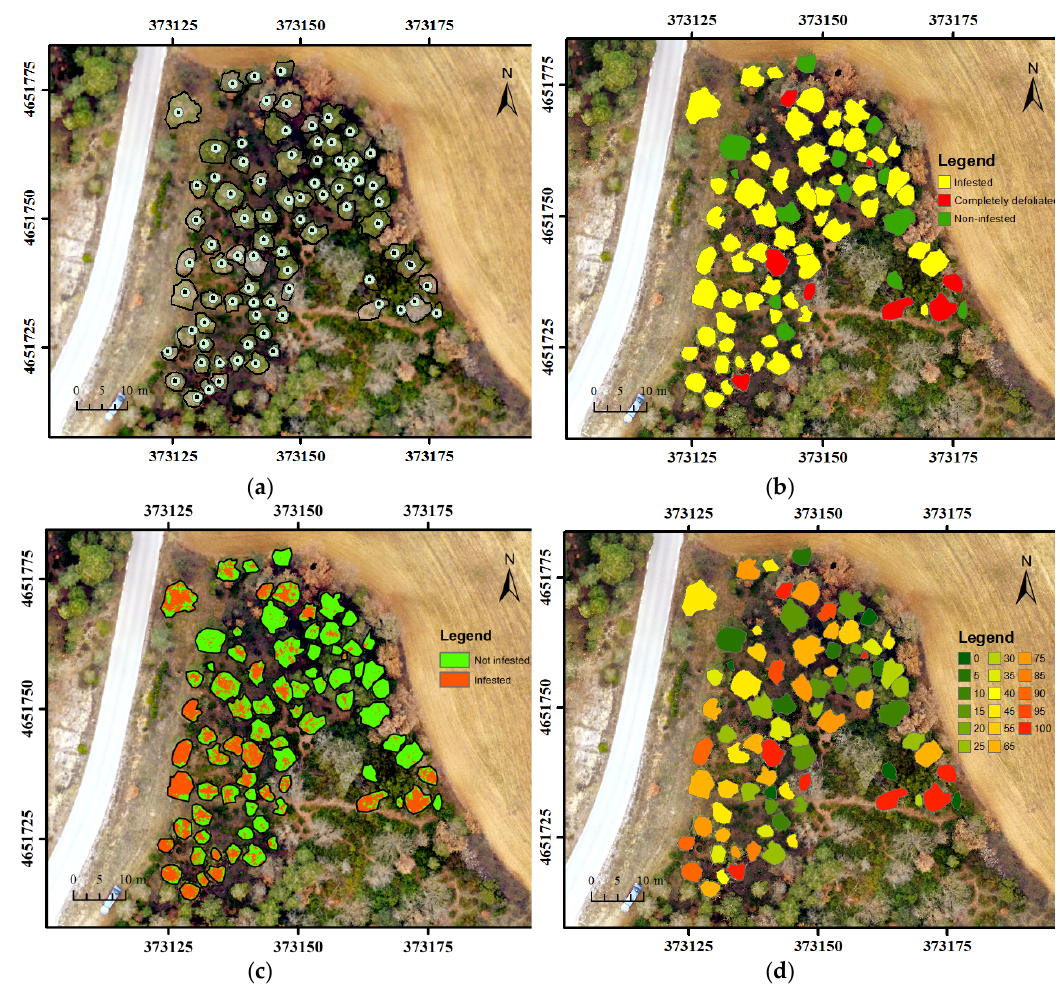
Figure 3. Pine processionary moth defoliation in the Torregassa forest site: ( a ) Manual segmentation of analyzed trees and a buffer of 1 m from the tree automatic identification point (blue segment) on the orthomosaic; ( b ) Visual tree classification in the field as infested (60), non ‐ infested (13) or completely defoliated (8); ( c ) Defoliation measured as infested or non ‐ infested using RGB images from unmanned aerial systems (RGB ‐ UAS) and the automatic classification; ( d ) Percentage of defoliation measured in the field. Table 1. Confusion Matrix for infested and non-infested trees measured in the field or classified using RGB-UAS